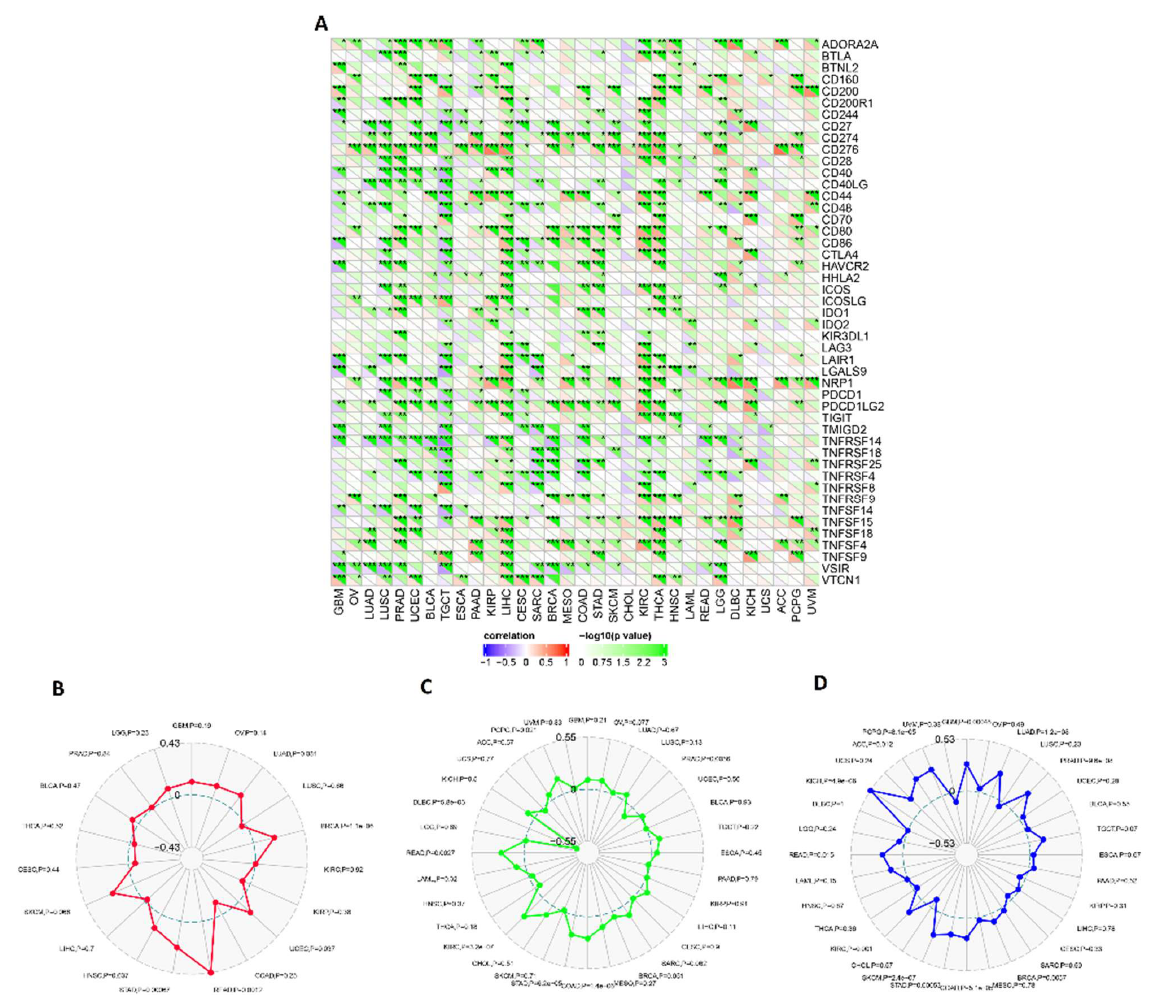
Figure 9. Correlations of ECT2 expression with immune checkpoints, tumor neoantigens, MSI, and TMB. ( A ) Heatmap correlating the immune checkpoints and ECT2 across a list of human tumors. ( B – D ) Radar charts showing the overlaps of ECT2 with tumor neoantigens, MSI, and TMB respectively. (*: p -value < 0.05; **: p -value <0.01; ***: p -value <0.001)